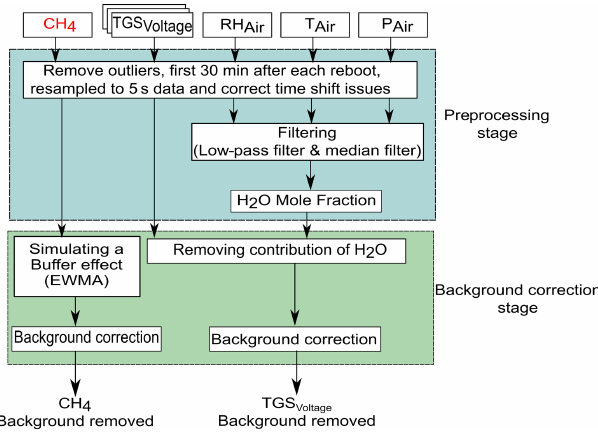
Figure 2. Data preprocessing diagram, correction of H 2 O effects, and separation of the spikes from background data in the time